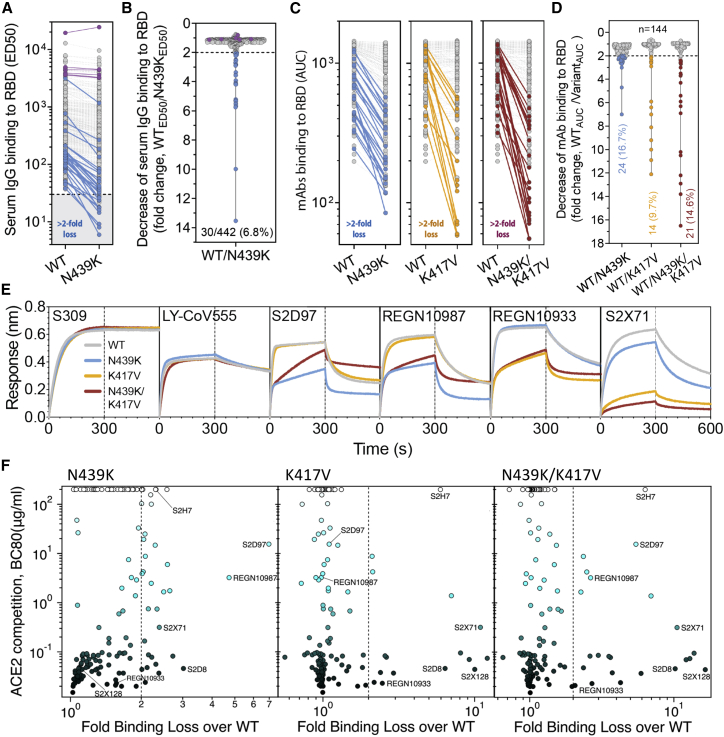
RBM variants exhibit escape from monoclonal antibodies and sera binding(A and B) Binding of serum and plasma samples from 442 SARS-CoV-2 infected individuals against WT and N439K RBD plotted as (A) ELISA ED50 for each RBD (cut-off for positive binding to WT set at 30) and (B) fold change relative to WT. Data shown are the average of two independent replicates (source data given in Data S1). Blue dots indicate sera with at least 2-fold loss of binding to the N439K RBD variant as compared to WT in both replicates. Purple dots indicate sera from individuals infected with SARS-CoV-2 N439K variant.(C and D) Binding of 140 mAbs from SARS-CoV-2 infected individuals and four clinical-stage or EUA-approved mAbs against WT, N439K, K417V, and N439K/K417V RBD, plotted as (C) ELISA AUC for each RBD and (D) fold change relative to WT. Data shown are the average of two independent replicates (source data given in Data S1). For all, the colored dots indicate mAbs demonstrating at least 2-fold loss of binding to the variant RBD as compared to WT (counted if the average of both replicates is at least 2-fold and each individual replicate is at least 1.7-fold).(E) Kinetics of binding to RBD variants by Octet of six representative mAbs (representative of n = 2 independent experiments).(F) Distribution of the 144 mAbs based on binding to RBD variants (expressed as fold-change over WT) and hACE2 competition (expressed as the mAb concentration blocking 80% of hACE2 binding, BC80, also indicated as a blue gradient; source data in Data S1). Higher BC80 values (lighter blue) correspond to less hACE2 competition, with mAbs indicated at the top of the panels (white) showing no competition at all.See also Figures S4, S5, and S6.